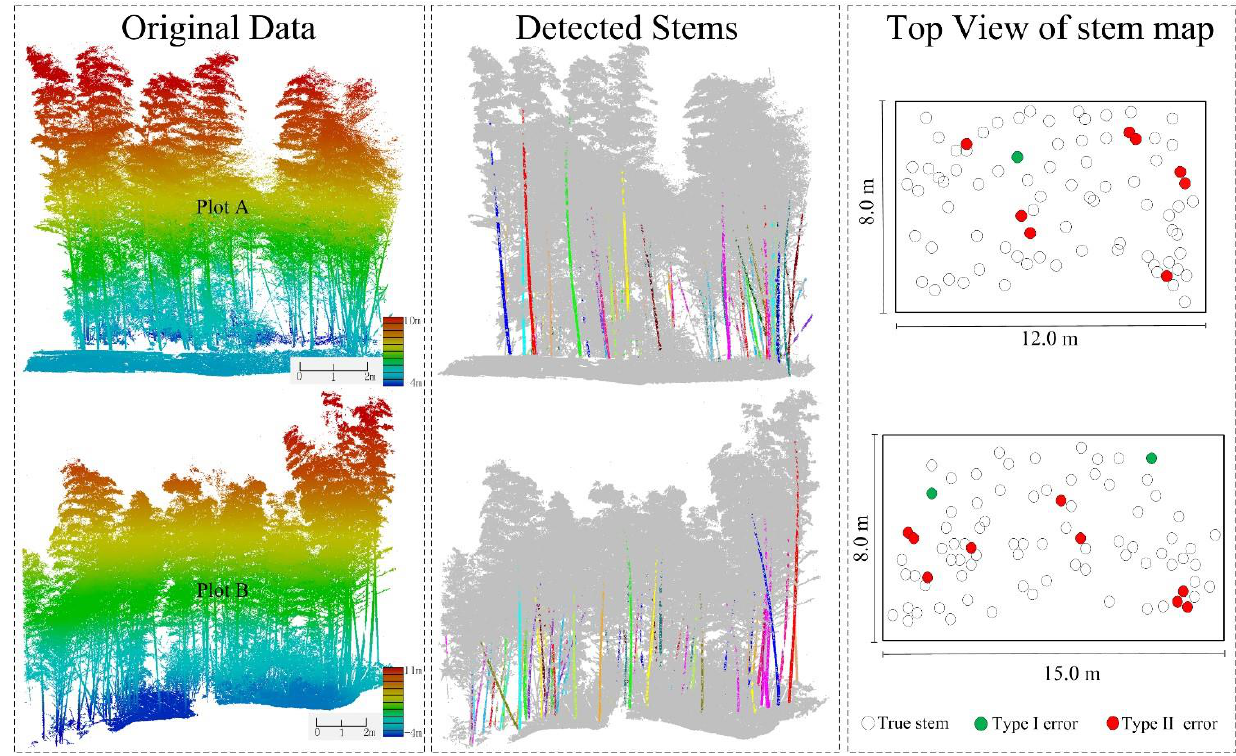
Figure 4. Original point clouds, detected stems and top view of stem detection